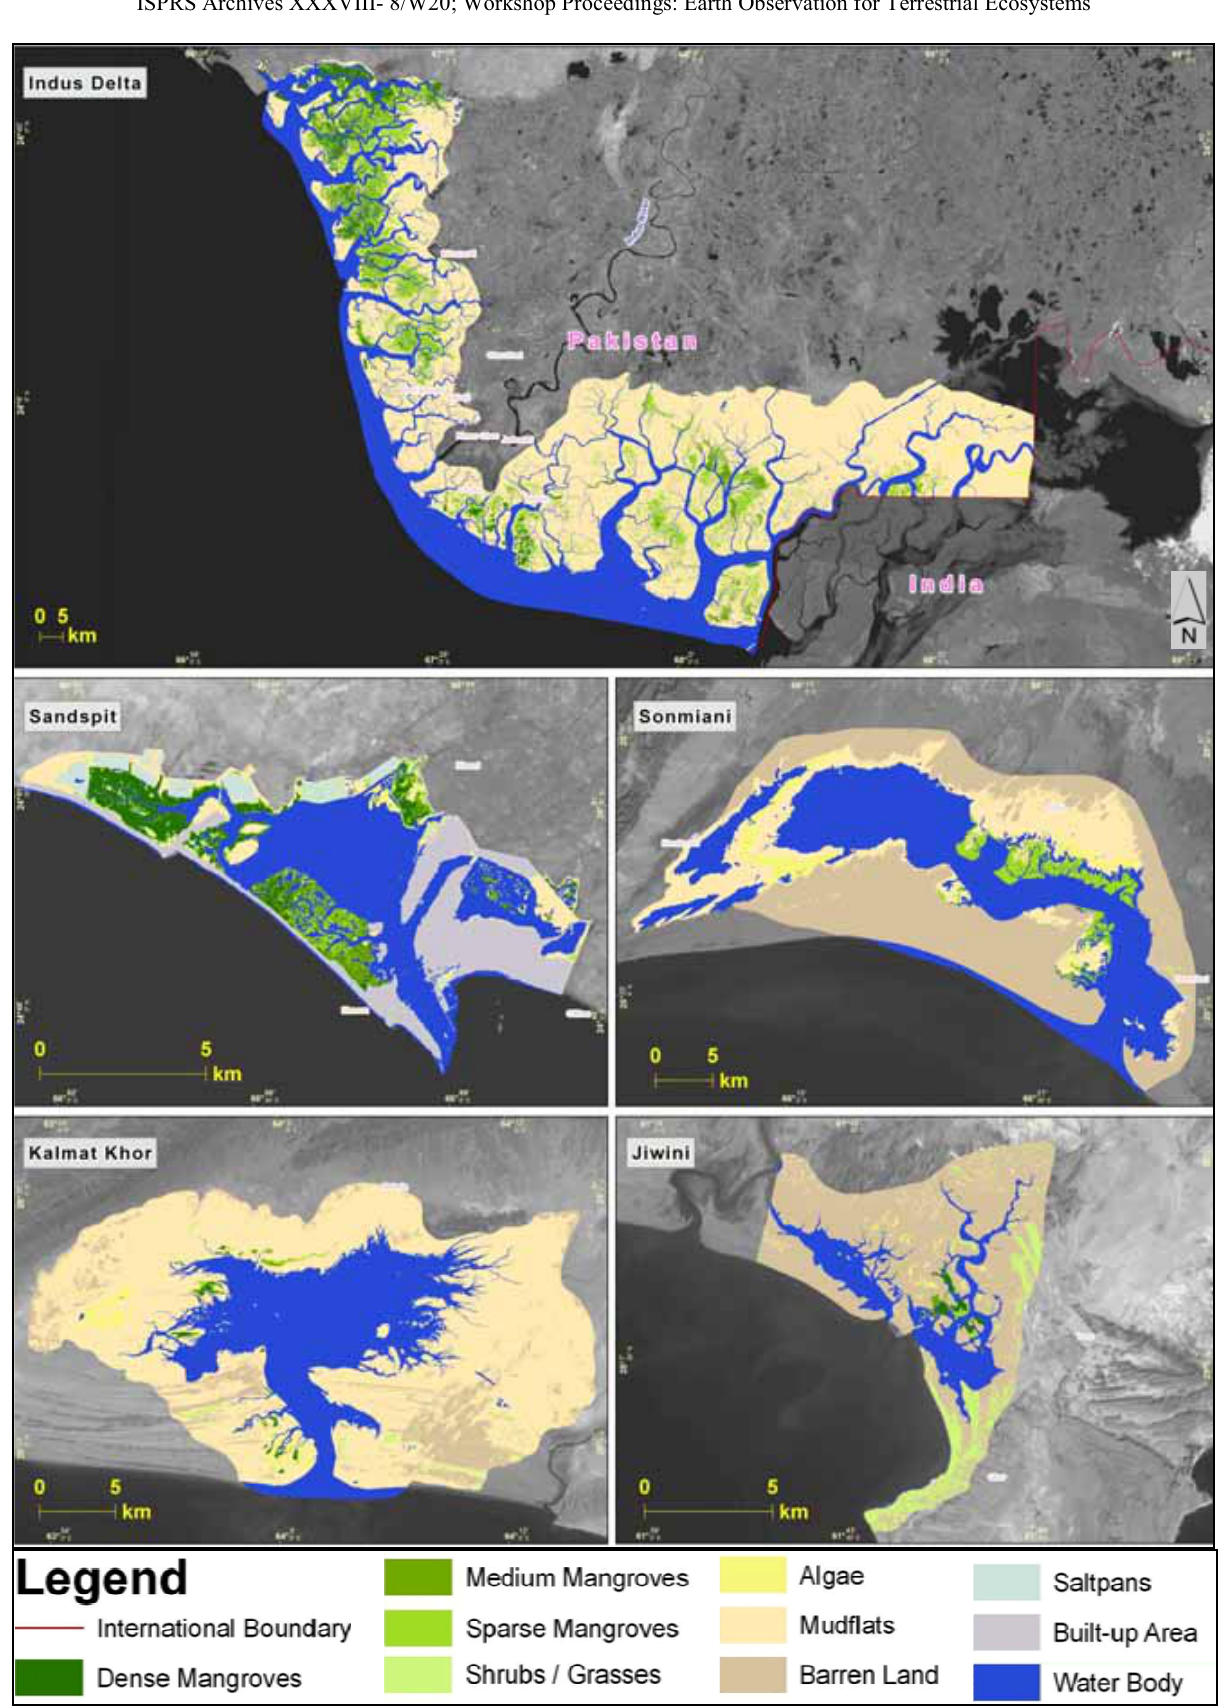
2: Land Cover Maps of Mangroves Forest Sites of